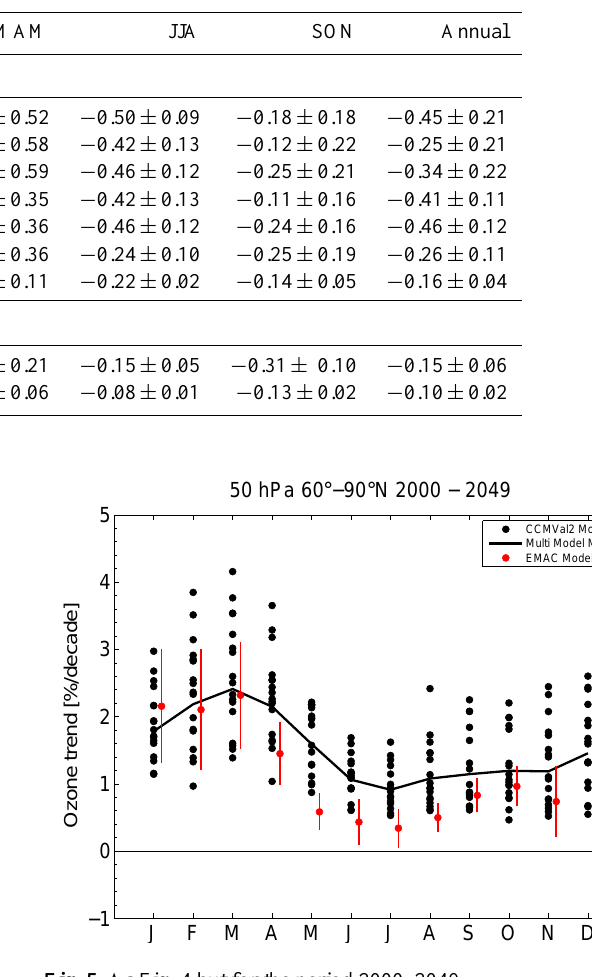
Fig. 5. As Fig. 4 but for the period 2000–2049.